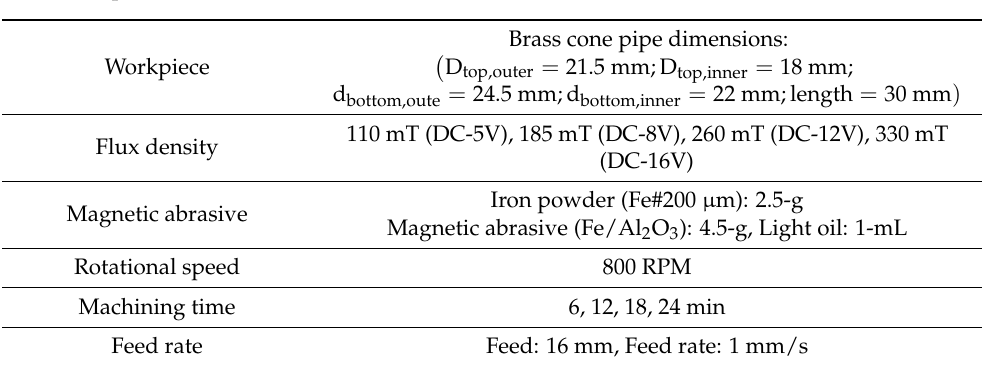
Table 3. Experiment